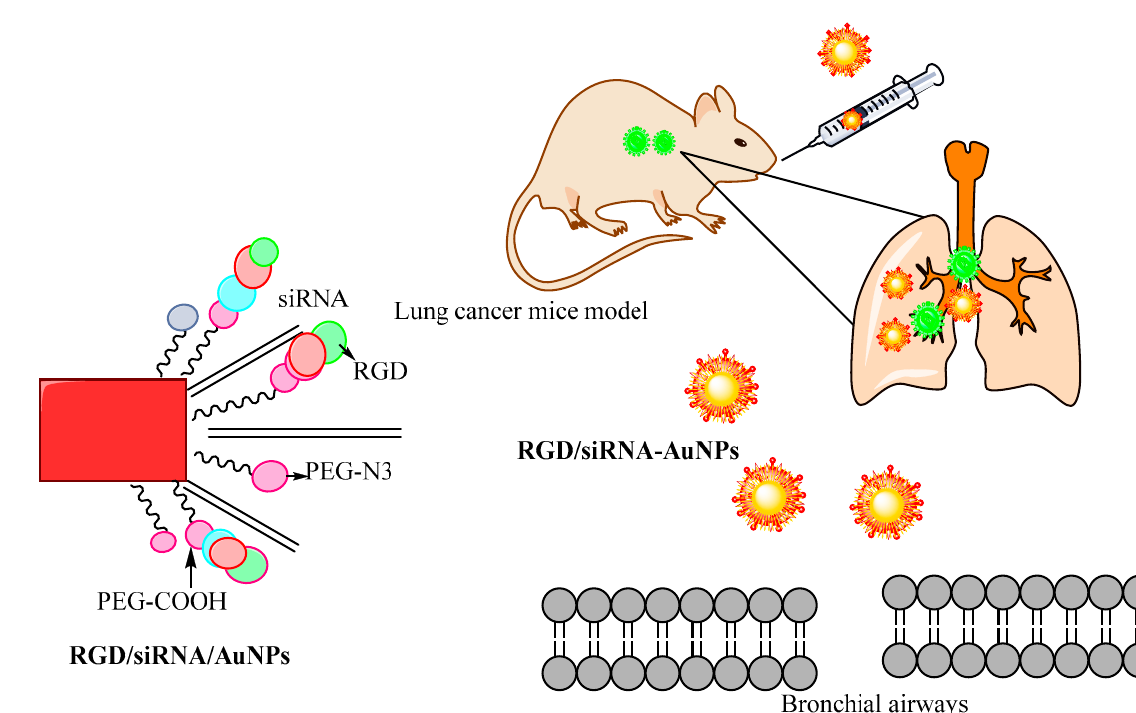
Figure 3. Inflammatory response and therapeutic siRNA silencing via RGD nanoparticles in a lung cancer mouse model.